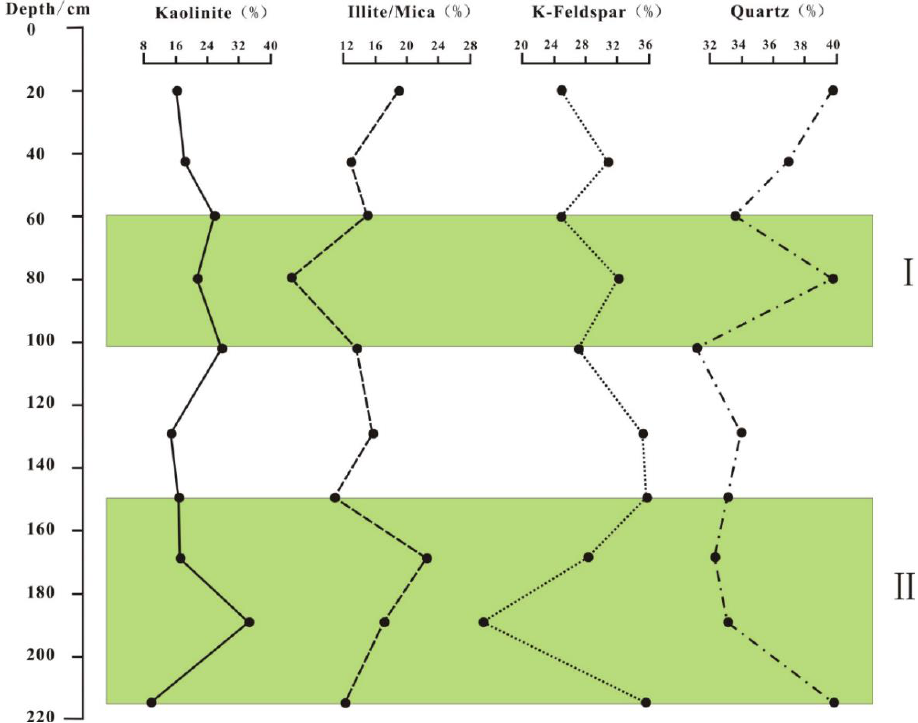
Figure 7. Clay and other mineral content in the Ganxian weathering profile.